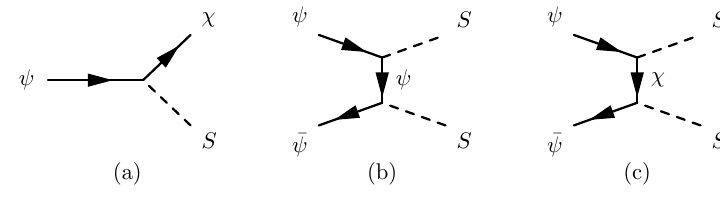
Figure 6 . Processes which connect to the thermal bath.